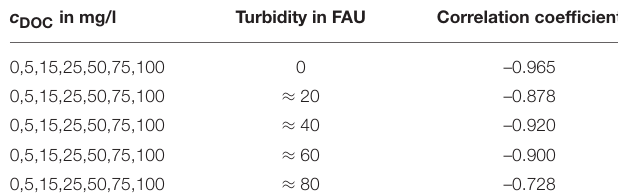
TABLE 2 | Correlation coefficients between the IR sensor signals and the different DOC concentrations for every turbidity value.